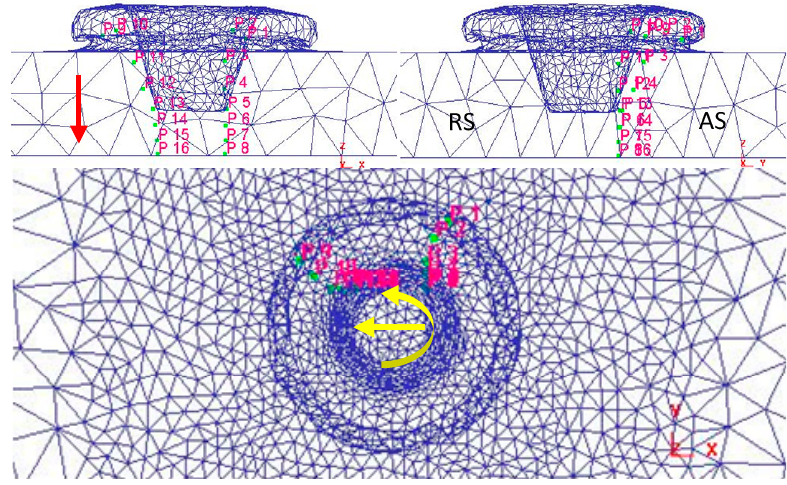
Figure 14. The trend of the particle flow during pressing.